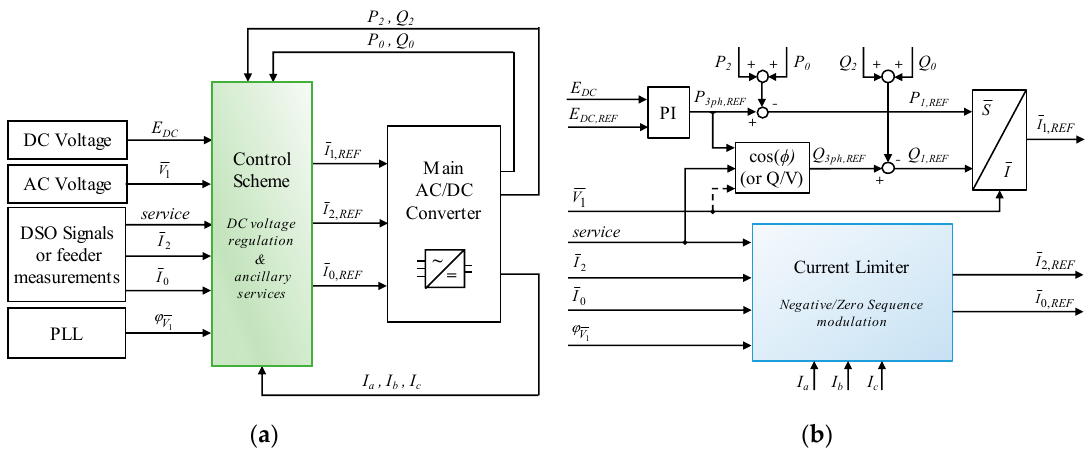
Figure 3. Control strategy for the bidirectional converter “ Main AC/DC Converter ”, which acts as an interface between the distribution network and the end-user: ( a ) Complete control scheme regulating the converter to both maintain a stable DC voltage at node 700_VDC and provide network ancillary services; ( b ) Inner structure of the block “ Control Scheme ” in ( a ), which evaluates the current reference signals.